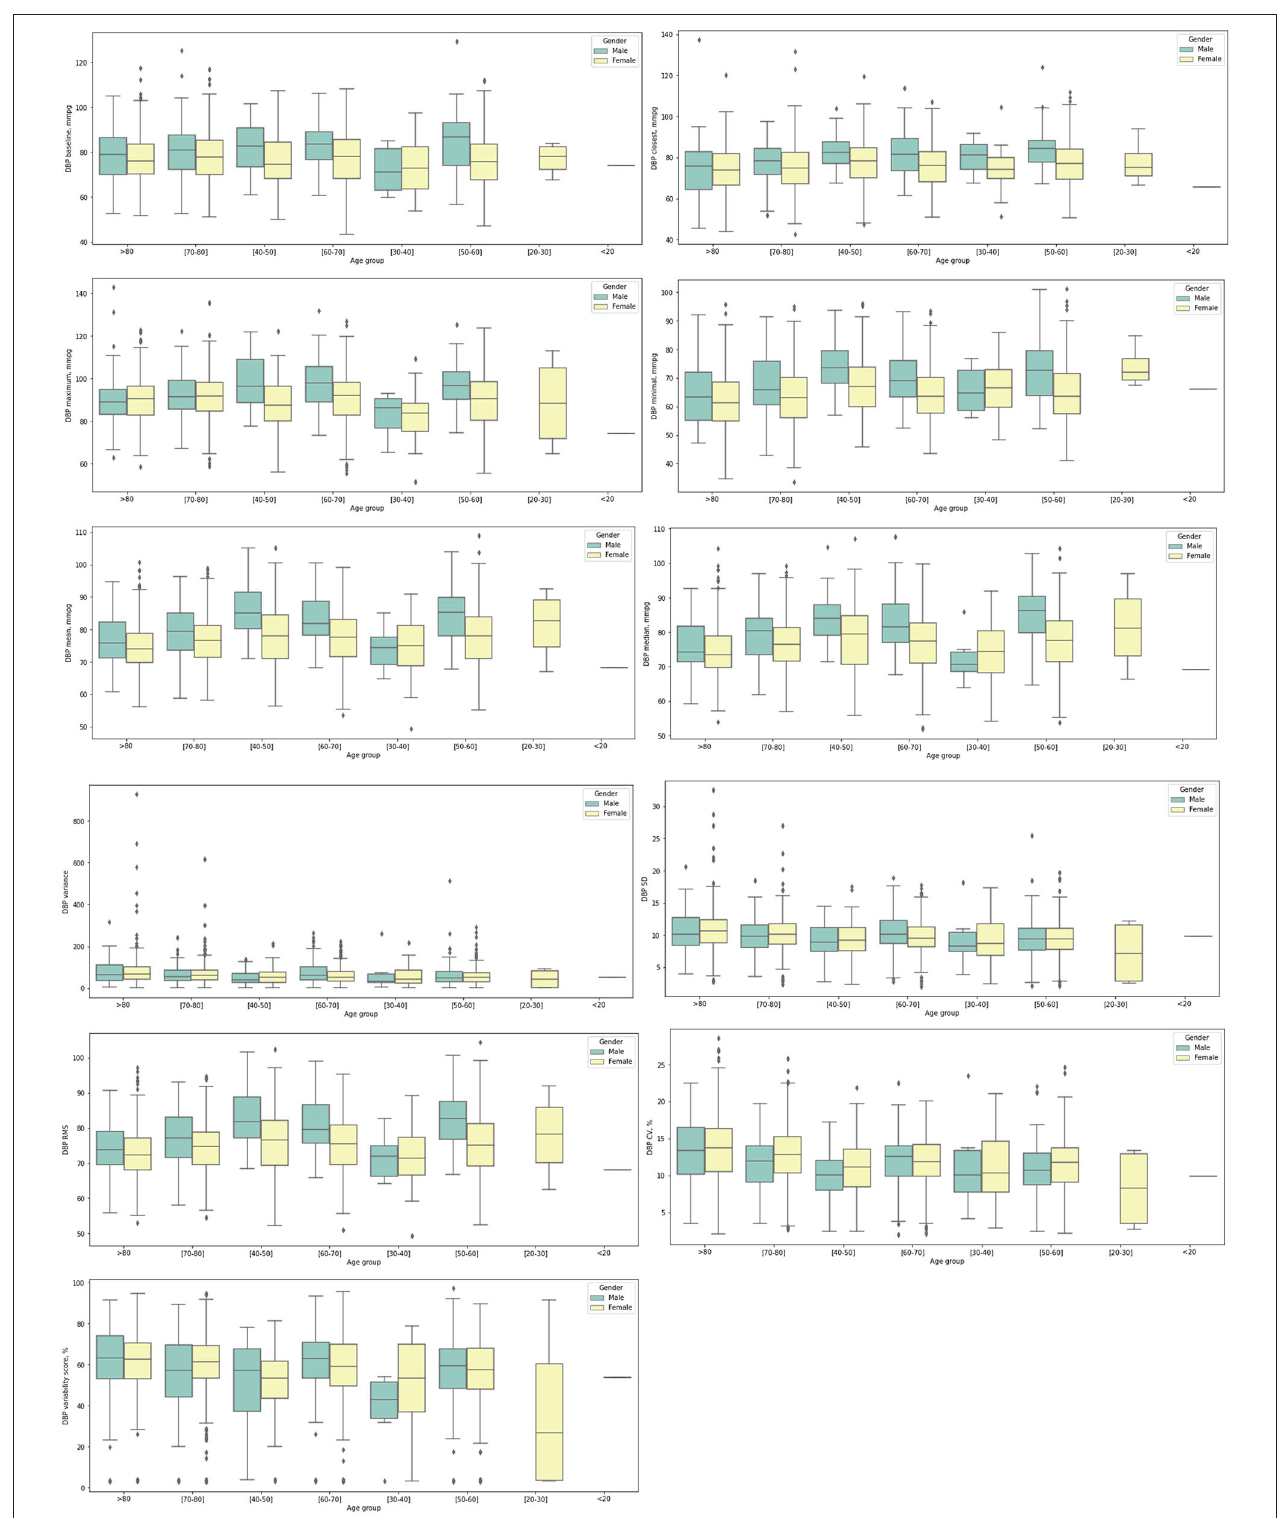
FIGURE 3 | Box plots showing diastolic blood pressure (DBP) measurements stratified by gender and age at anxiety presentation.